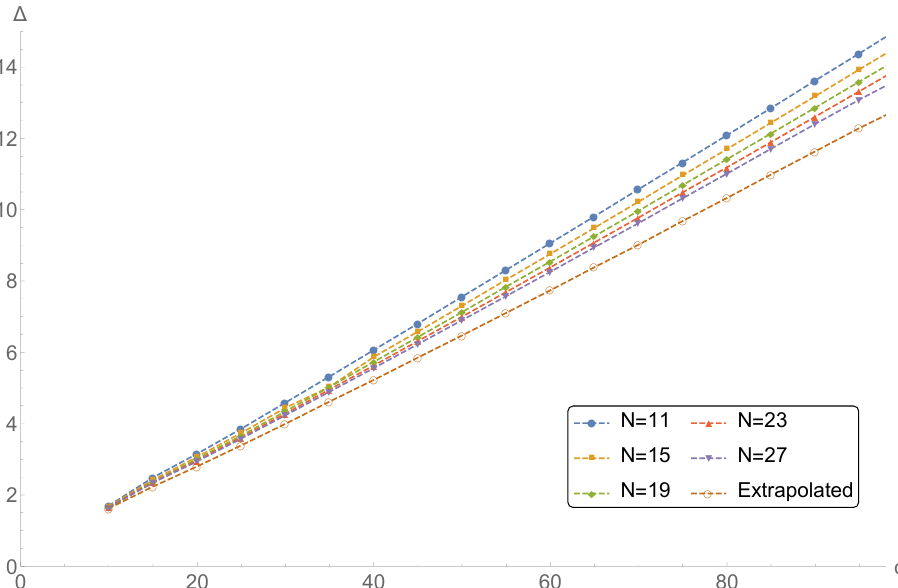
Figure 12 . The upper bound on the dimension of the lowest charged primary in N = (2 ; 2) SCFT. The bound improves as we increase N